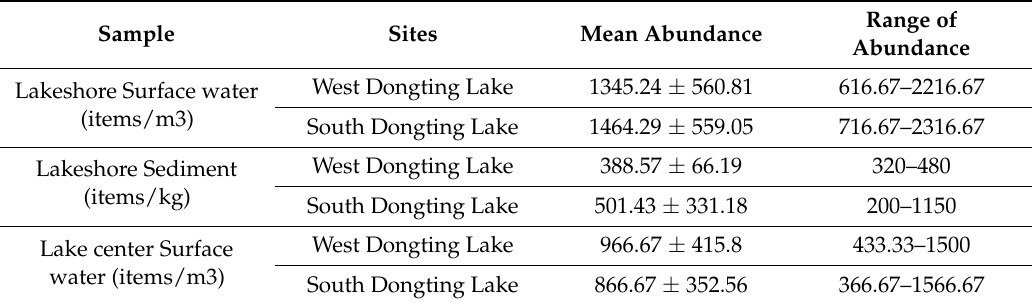
Table 2. Abundance of microplastics collected from surface water and